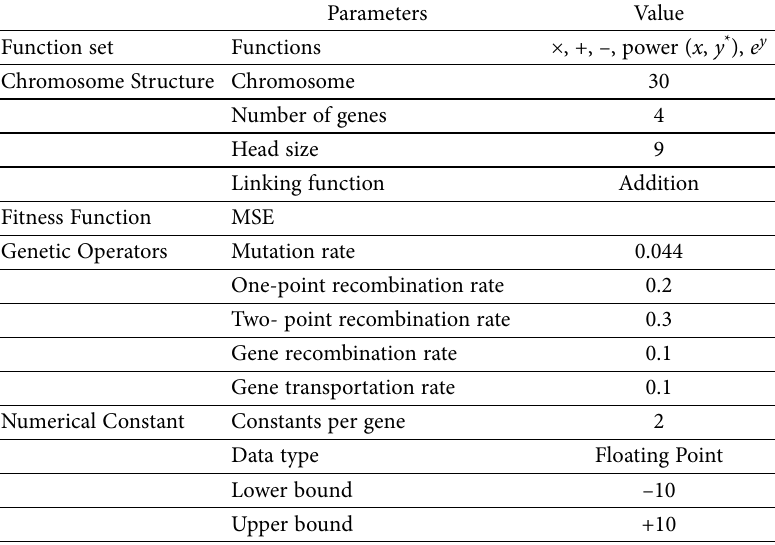
Table 4. GEP parameters